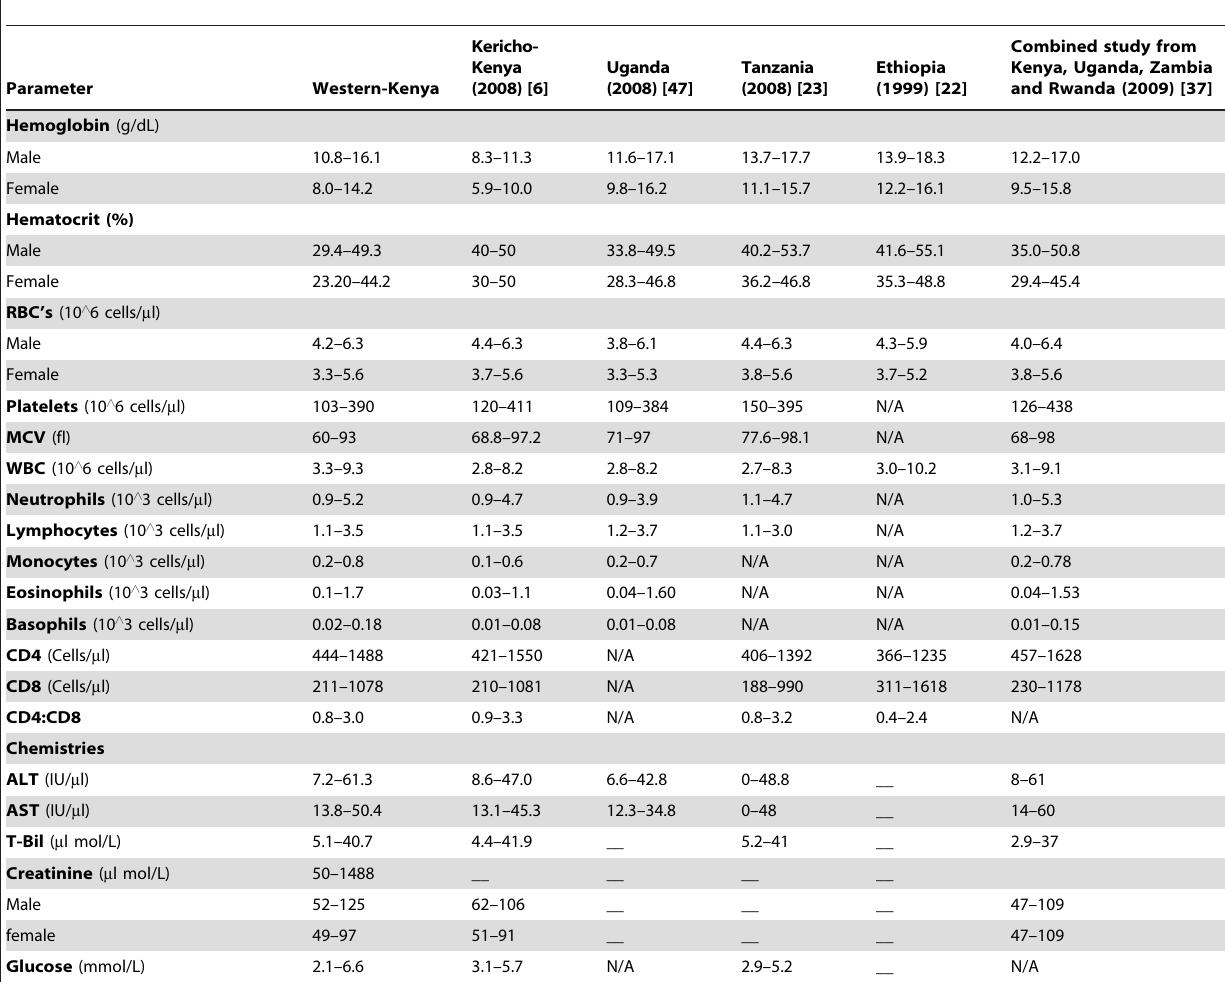
Table 4. Hematological and Biochemistry Laboratory reference ranges derived from rural Western Kenya compared to other sources in Africa.